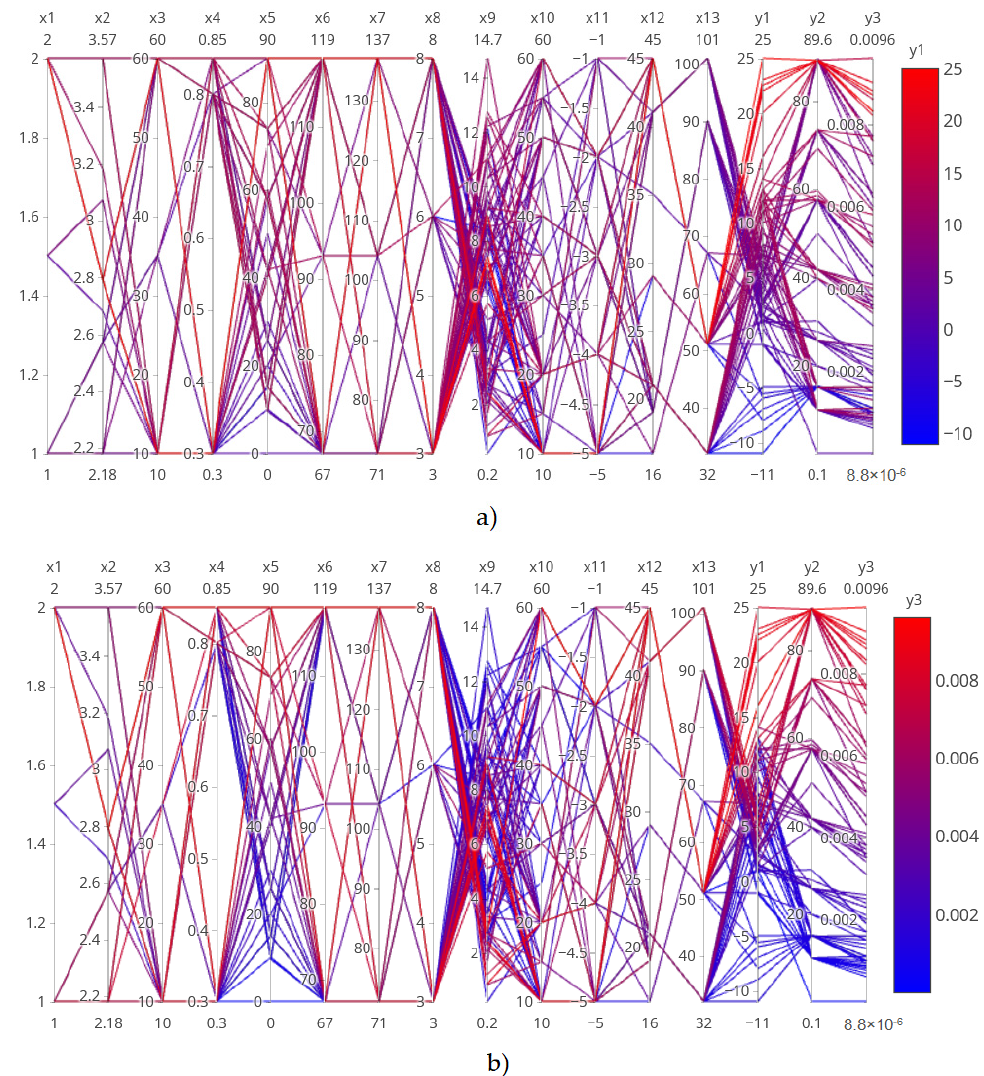
Figure 2. All CFD results derived from 77 crystal growth recipes shown in parallel coordinate system for inputs x 1 –x 13 and outputs y 1 –y 3 . The line color matches the value of: ( a ) the interface deflection y 1 and ( b ) v/G = y 3 . The database was used for ML analysis.